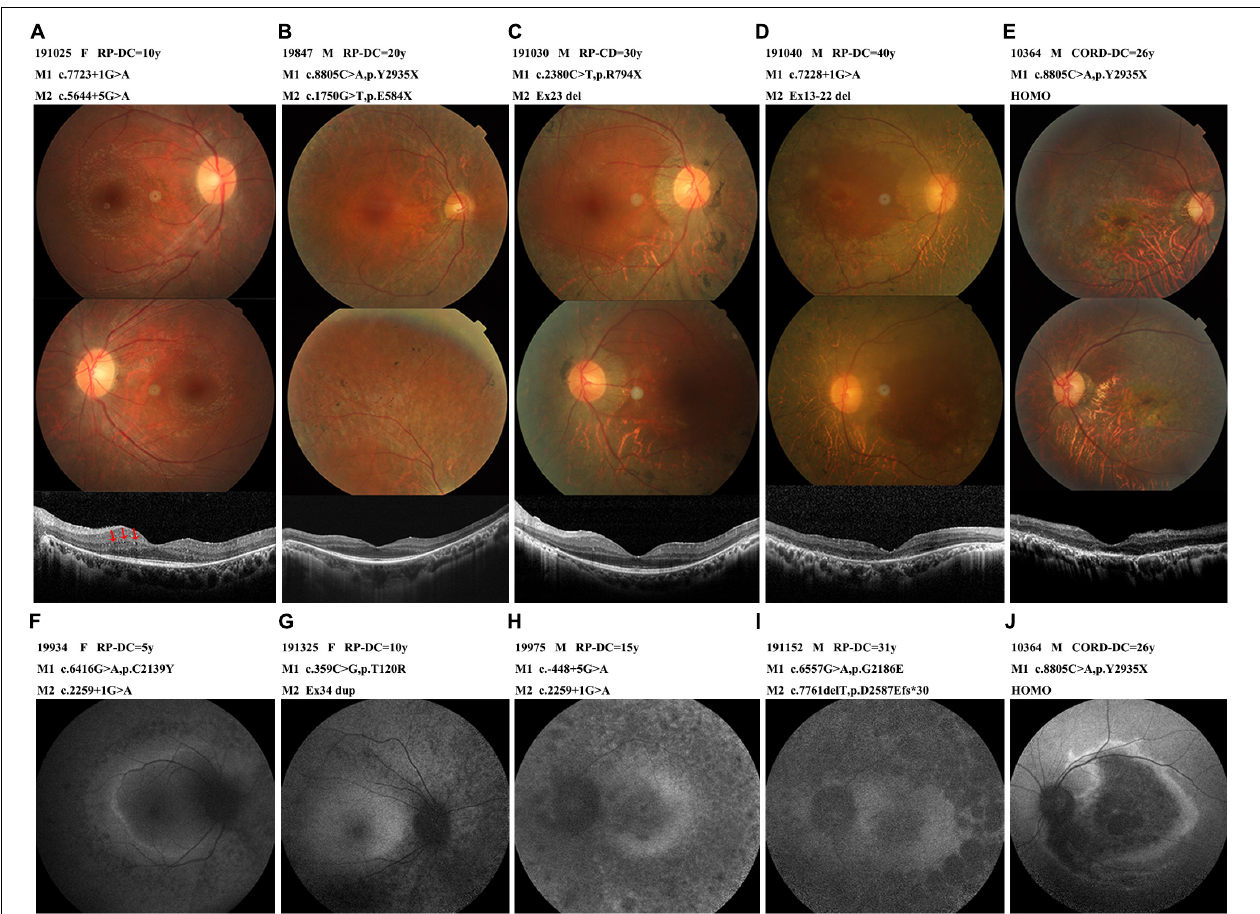
FIGURE 4 | The photographs characteristics of the patients with different courses. (A) A 22-year-old female (191025) diagnosed with RP, showed RPE atrophic changes outside the vessel arcade without pigmentation, OCT with some cysts in the inner nuclear layer (arrow-heads). (B) A 44-year-old male (19847) diagnosed with RP, pigmentations were scattered in the peripheral retina. OCT showed relatively preserved macular structure. (C) A 43-year-old male (191030) diagnosed with RP, extensive choroid atrophy with minimal residual RPE outside the macular region. OCT showed ellipsoid and interdigitation zone discontinuity. (D) A 47-year-old male (191040) diagnosed with RP, showed the fundus appearance of the end-stage of the disease, widespread RPE and choroidal atrophy, bone spicules and vascular thinning were evident, macular affected. OCT showed thinning of the outer retina, ellipsoid completely disappeared, RPE atrophied with high reflection sediments. (E,J) A 31-year-old male (10364) diagnosed with CORD, marked atrophy of macular, OCT showed full retinal layers thinned, severe atrophy of the outer retina. Dark macular area and a hyperfluorescent ring within the vascular arcade in AF. (F,G,H,I) Autofluorescence images from early to late-stage disease. Hyper auto-fluorescent ring at the posterior pole in the early stages, evolve into low fluorescence in the whole field of view. Abbreviations: DC, disease course. HOMO, homozygosis. M, mutation.